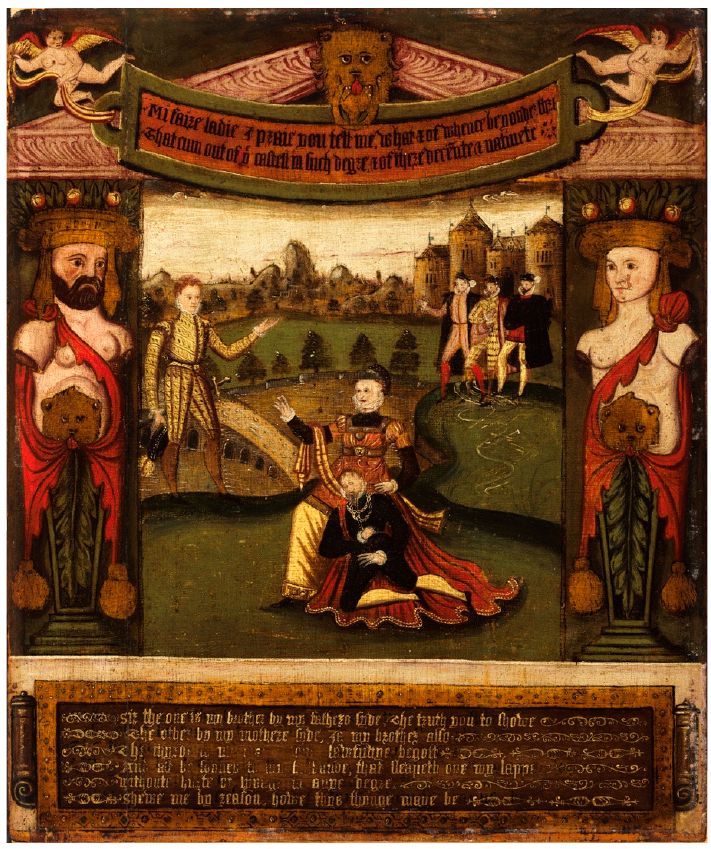
Figure 16. Unidentified Artist, ‘The Allegorie of a Faire Ladye’, 1570–1579, oil on panel, Harvard Art Museums/Fogg Museum, Gift of Robert Rantoul Endicott, Photo © President and Fellows of Harvard College, 1959.143, 45.7 cm × 54.3 cm (18 × 21 3/8 in.) Harvard Art Museums collections online, https://hvrd.art/o/228438 (accessed on 5 January 2022).